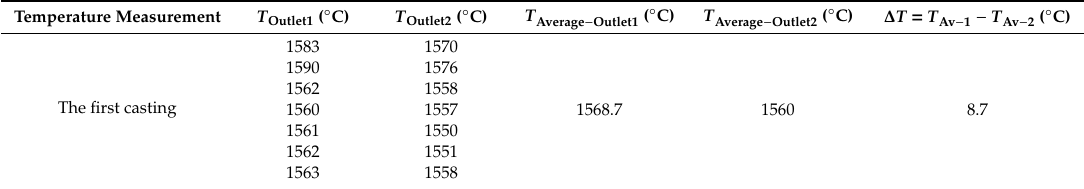
Table 6. The measured temperature of molten steel at di ff erent outlets in the original tundish. Temperature Measurement